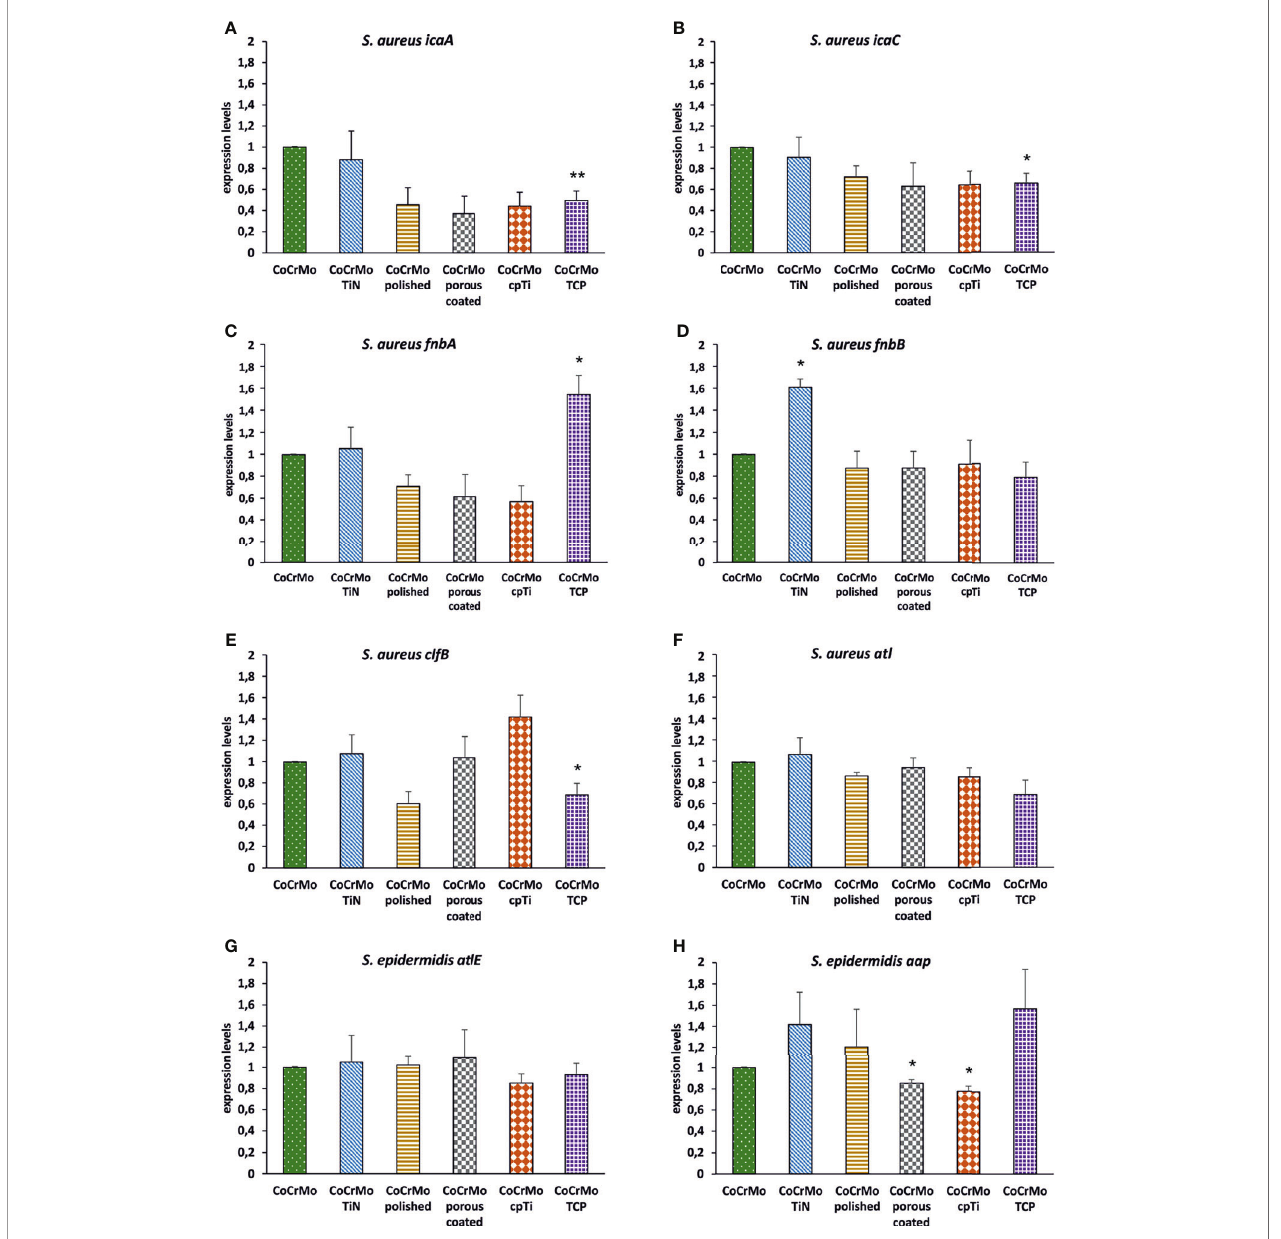
FIGURE 7 | Expression levels of bio fi lm-associated genes. S. aureus ( A – F ; n = 3) and S. epidermidis ( G , H ; n = 3); error bars show the standard error of the mean; statistically signi fi cant differences to CoCrMo are marked * (p